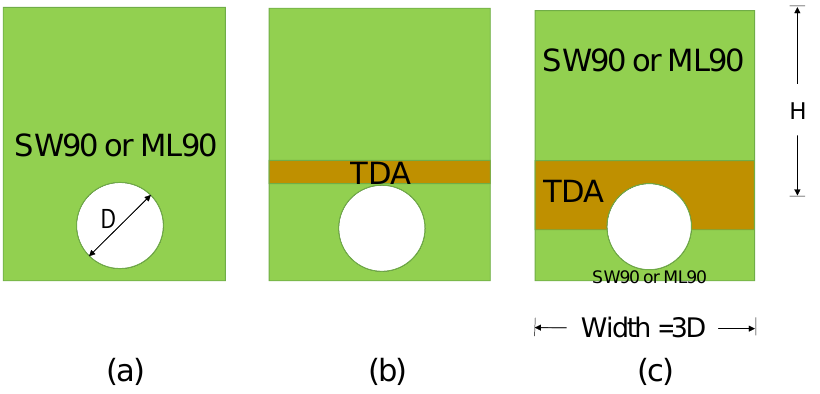
Figure 2. Trench configurations employed in the present study: ( a ) trench configuration 1; ( b ) trench configuration 2; and ( c ) trench configuration 3.